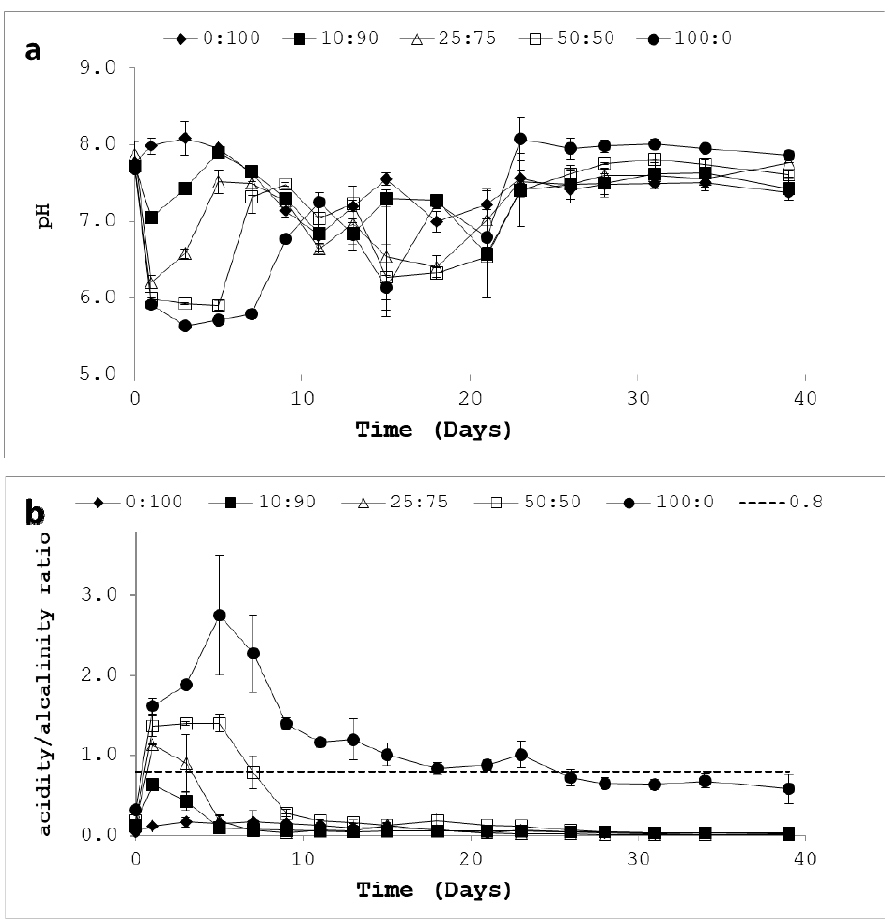
/ alkalinity ratio evolution ( b ) in all ESBP:PM Figure 2. pH evolution ( a ) and acidity/alkalinity ratio evolution ( b ) in all ESBP:PM ratios. Figure 2. pH evolution ( a ) and acidity